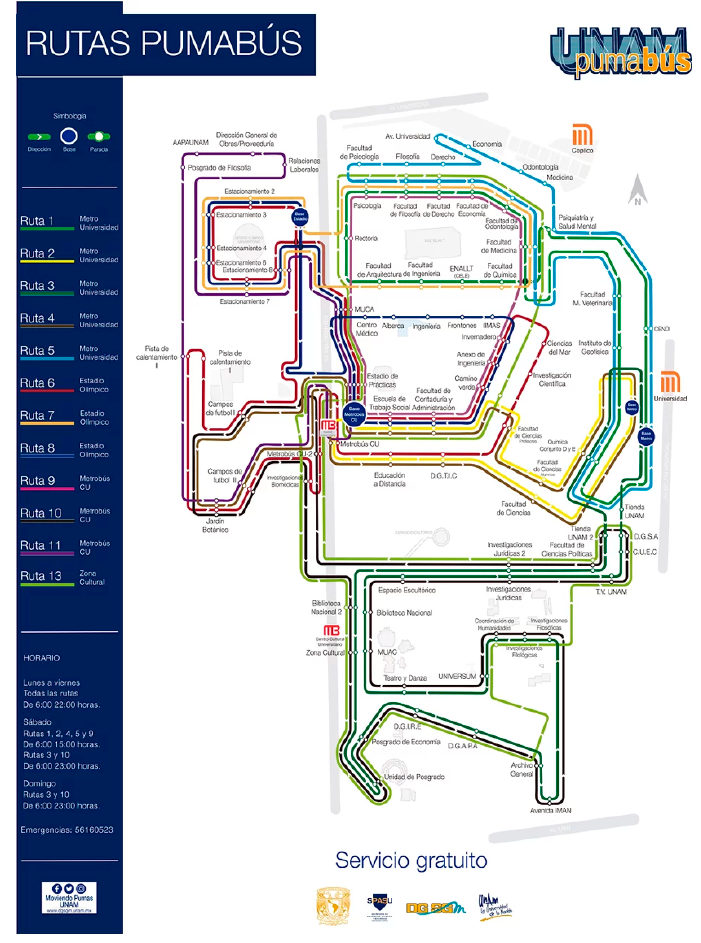
Figure 1. UNAM transport system routes and stations. Source: https://www.dgsgm.unam.mx/pumabus (accessed on the 15 January 2022).